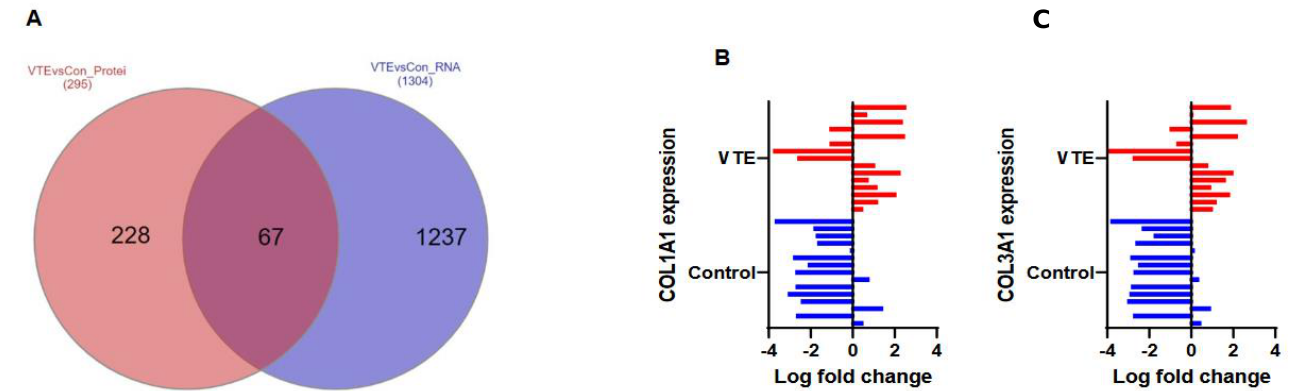
Figure 4. Co-altered proteins and transcripts between the VTE and control groups. ( A ) Comparison of co-quantified protein and transcript alterations in VTE vs. control tissue (LIMMA, p < 0.05, FC ± 1.5). ( B ) Differential protein expression matrix in collagen 1A1 between control (blue) and VTE (red); the X -axis represents log-fold change, p = 0.00093. ( C ) Differential protein expression matrix in collagen 3A1 between the control (blue) and VTE (red) groups, p = 0.00032.